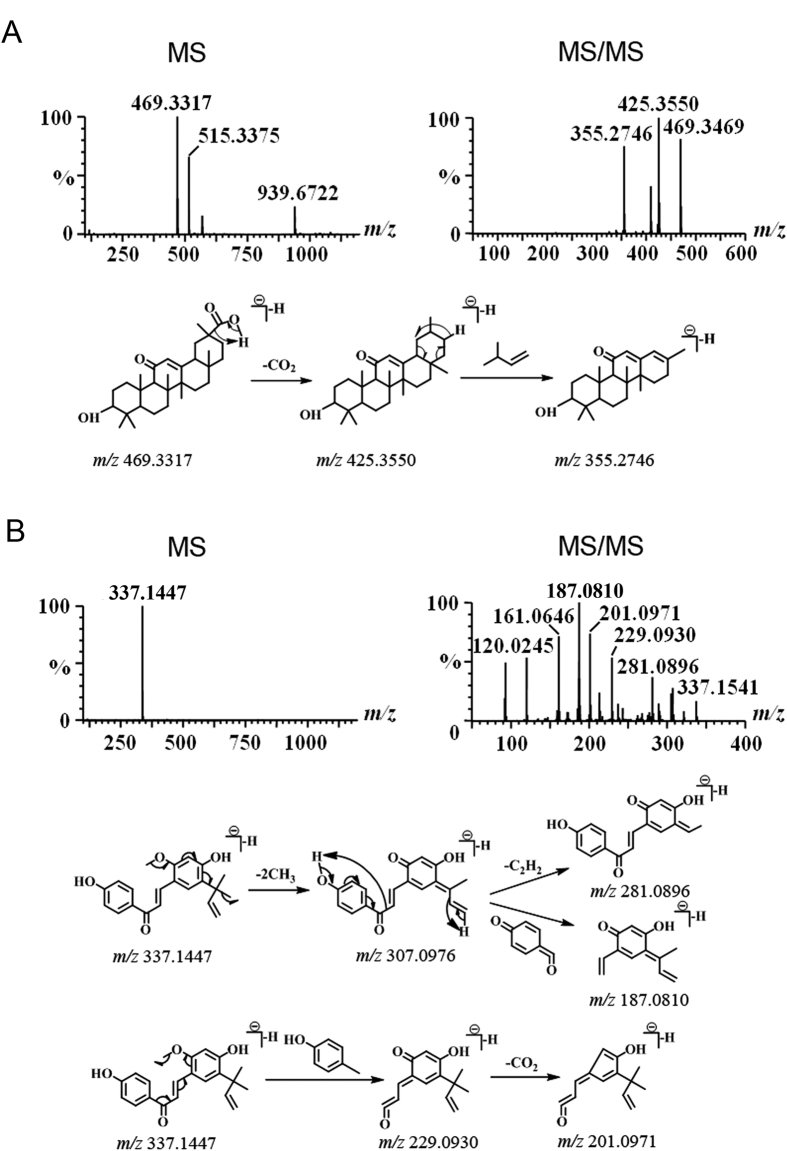
Structural elucidation of GC7 (A) and GC13 (B) by MS and MSMS analysis.The proposed fragmentation pathway is shown below mass spectra.